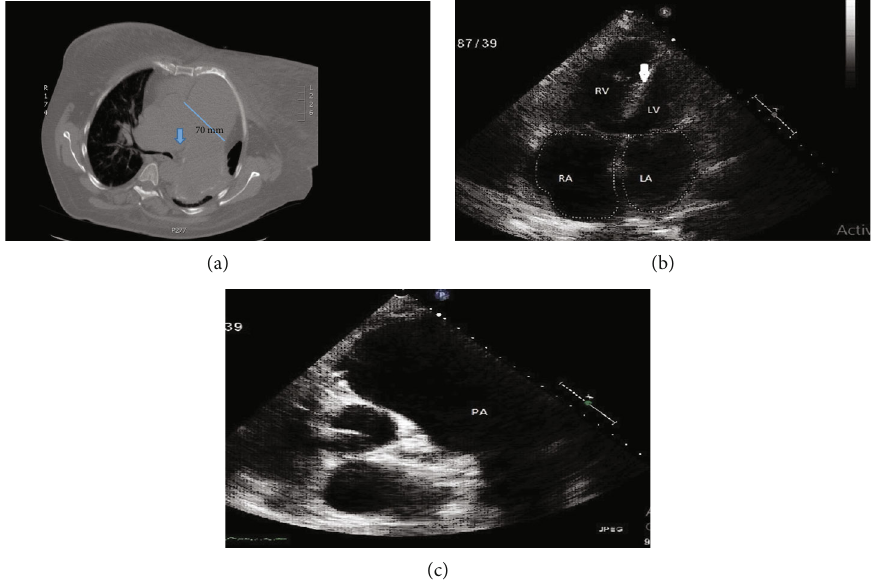
Figure 1: (a) Noncontrast chest CT showing main pulmonary artery aneurysm measuring 70 mm with blue arrow pointing the possible intimal fl ap. Rapid tapering of pulmonary vessels can be appreciated on the right lung zones. (b) Transthoracic echocardiogram apical four-chamber view showing severely dilated right ventricle and septal fl attening (white arrow). (c) Transthoracic echocardiogram parasternal short axis view at the level of aortic valve showing severe dilation of pulmonary artery.